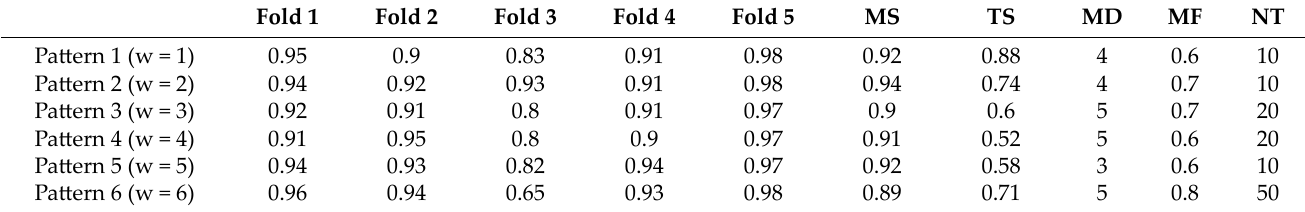
Table 1. R 2 of CV and grid search for